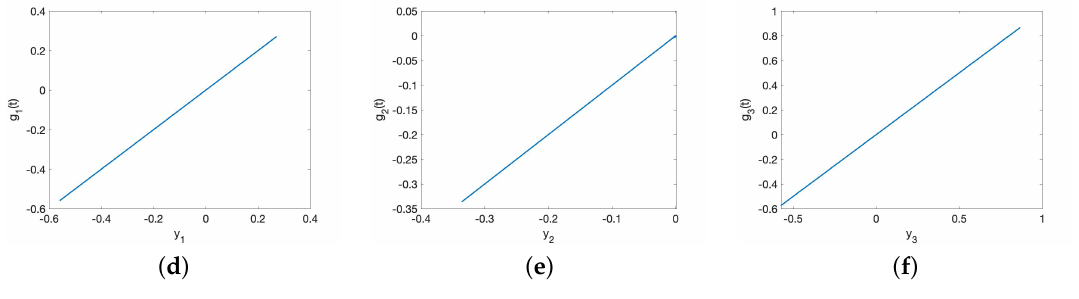
Figure 8. GS for modified UR model and HP model with initial data [ x 1 ( 0 ) , x 2 ( 0 ) , x 3 ( 0 )] = [ 0.001,0.001,0.001 ] and [ y ( 0 ) , y ( 0 ) , y ( 0 )] = [ 0.001,0.001,0.001 ] . ( a ) Phase plot for x 2 3 1 ( b ) Phase plot for y 1 and y 2 . ( c ) Time series plot for x 3 and y 3 . ( d ) y 1 − g 1 plot showing 1:1 correlation. ( e ) y 2 − g 2 plot showing 1:1 correlation. ( f ) y 3 − g 3 plot showing 1:1 correlation.